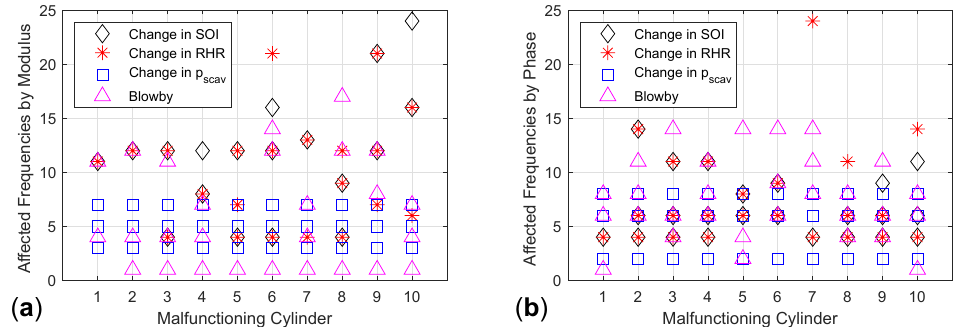
Figure 7. Mapping of individually occurring malfunctioning conditions for each cylinder showing the harmonic frequencies with the most affected ( a ) modulus and ( b ) phase angle, at 100%